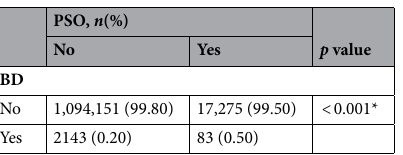
Table 3. Prevalence of psoriasis by Behçet disease status. BD, Behçet disease; PSO, psoriasis. *Statistically significant for p <